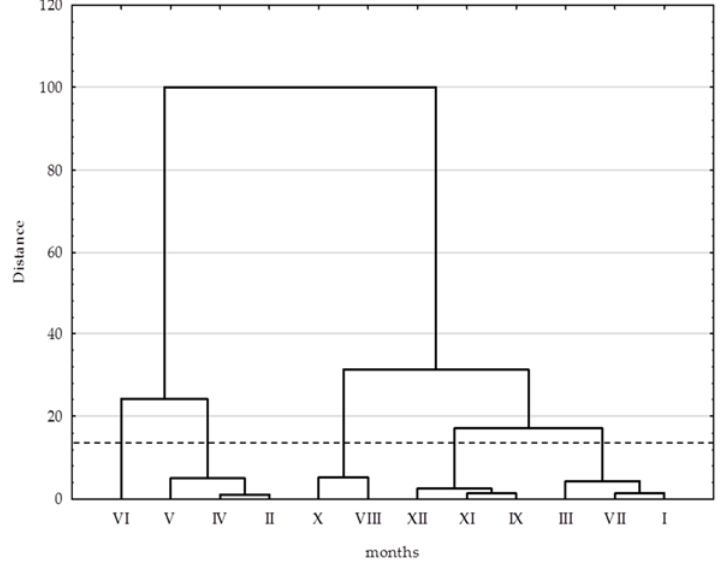
Figure 6. The agglomeration of the analyzed time periods in relation to the volumes of the sewage outflow.